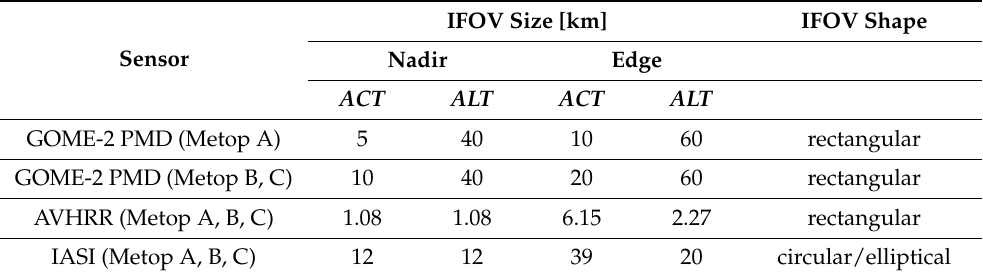
Table 2. Size and shape of the footprints considered by the colocation algorithm developed for PMAp. ACT and ALT refer to across-track and along-track,